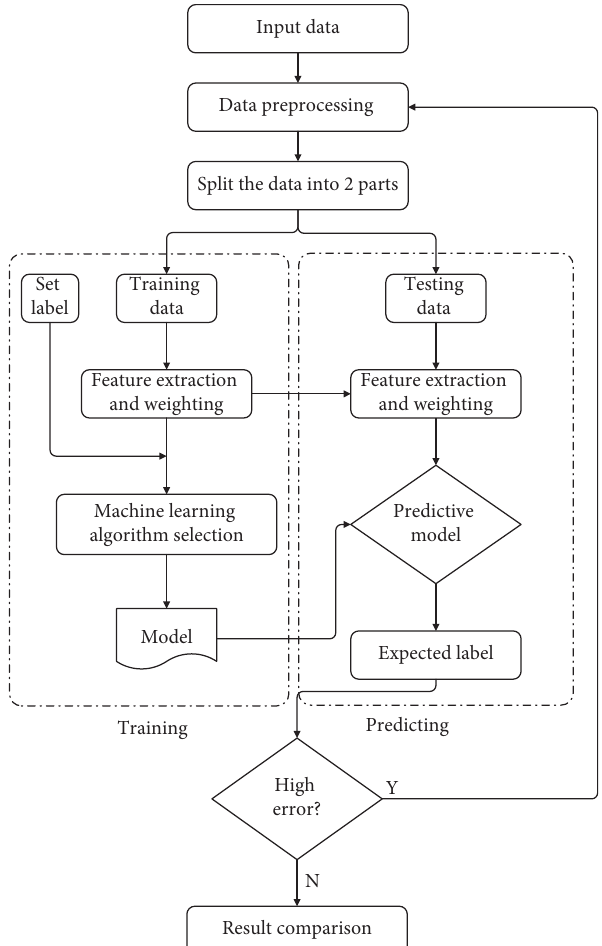
Figure 1: The architecture of the proposed